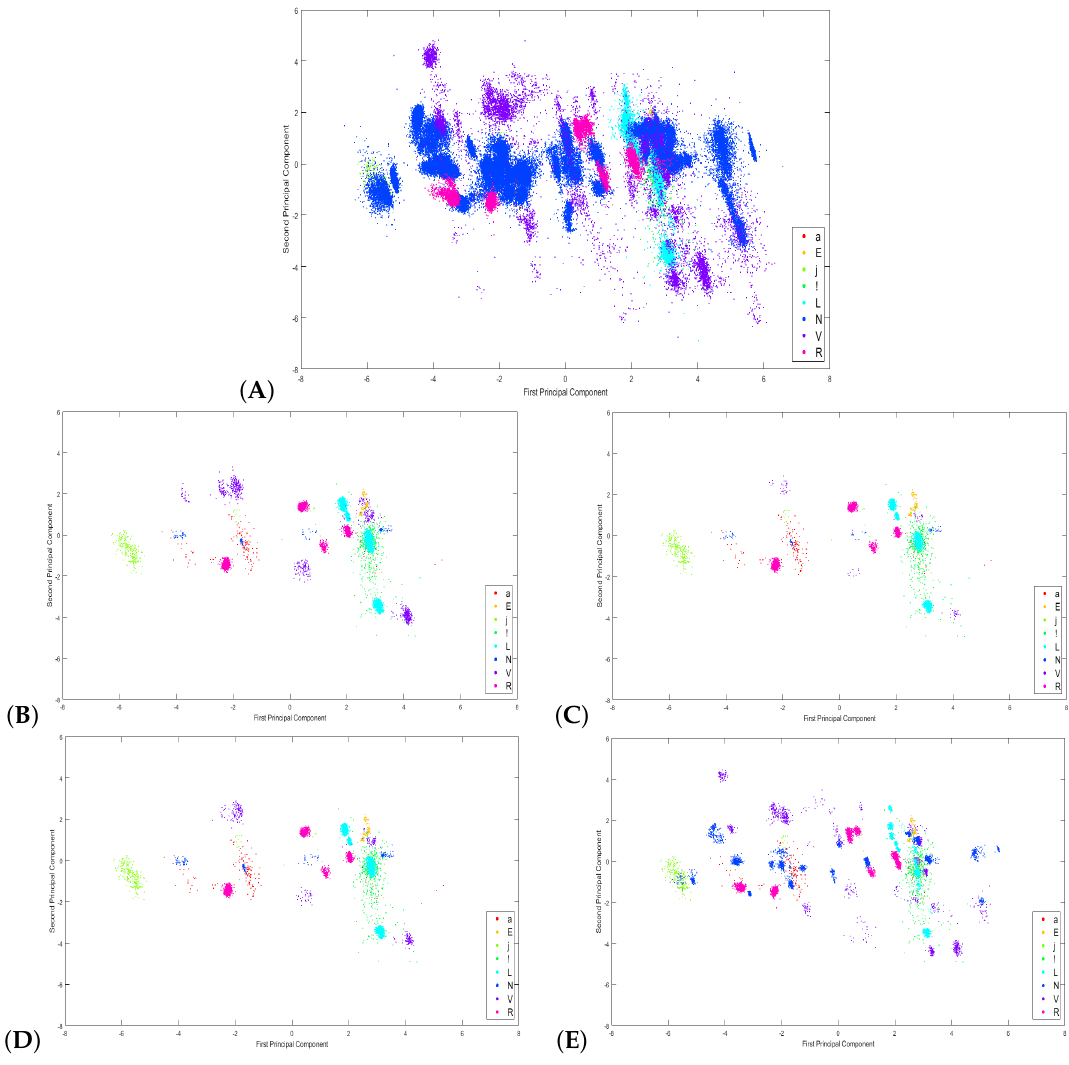
Figure 12. ( A ) Scatter plot of instances on the full dataset. ( B ) Scatter plot of instances on the experiment 1 dataset. ( C ) Scatter plot of instances on the experiment 2 dataset. ( D) Scatter plot of instances on the experiment 3 dataset. ( E ) Scatter plot of instances on the experiment 4